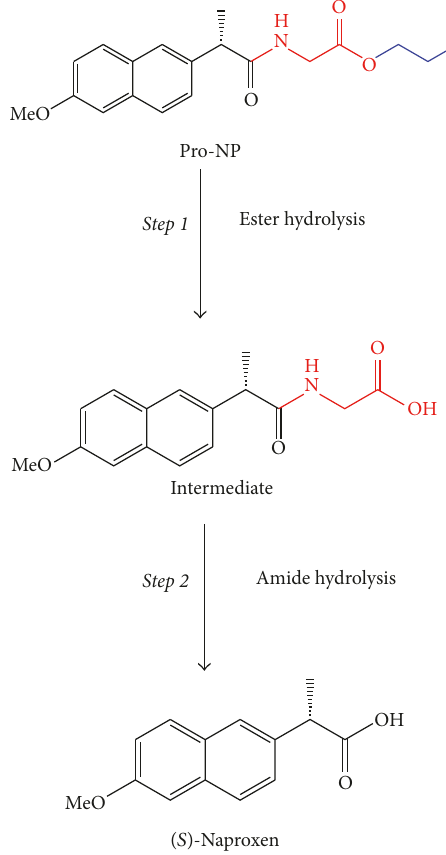
Figure 5: The degradation pathway of